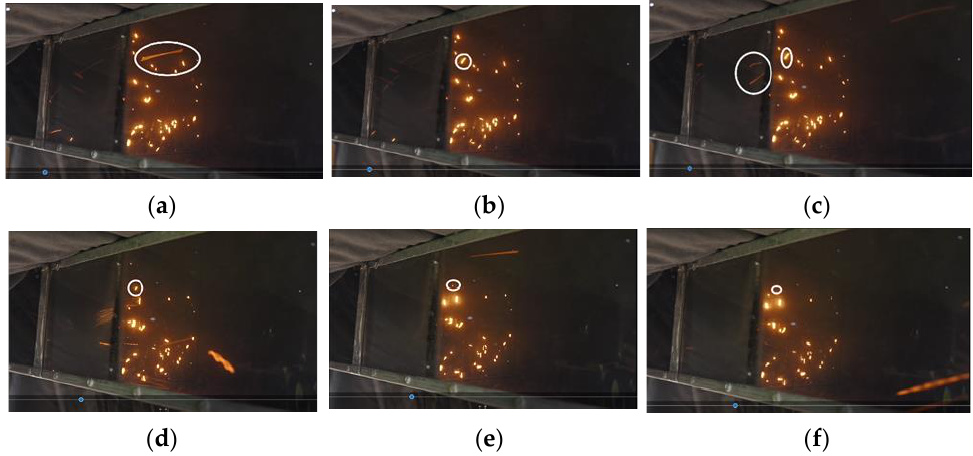
Figure 9. Continuation of burning firebrands behind the mesh for 12.68 s. The encircled firebrand